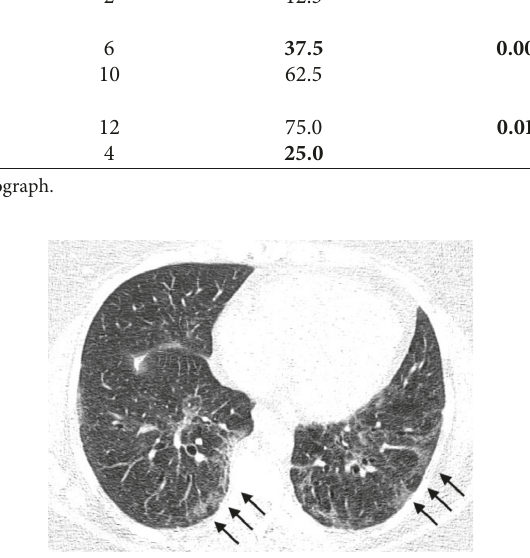
Figure 2: Chest CT in a lung window. An axial section at the level of the lower lobes. Subpleural ground-glass opacities (arrows).